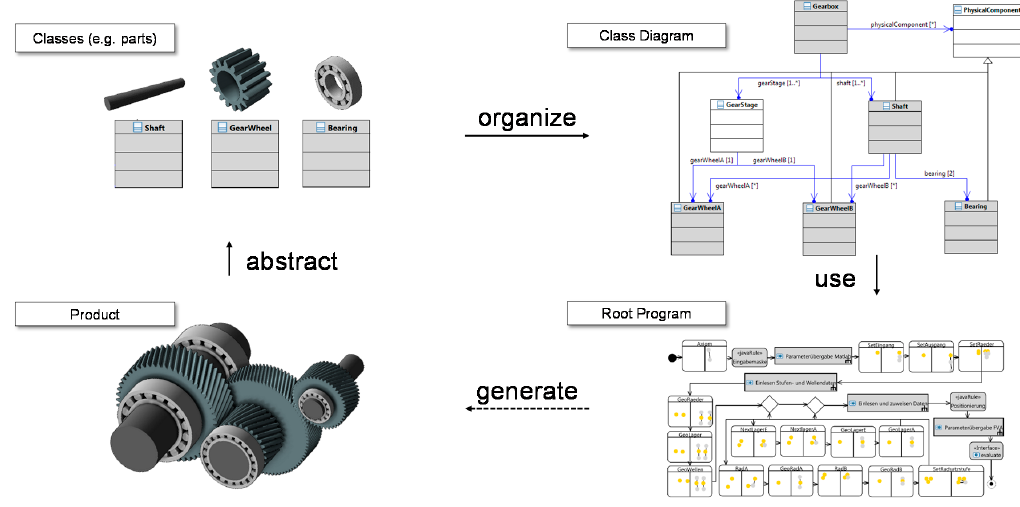
Figure 10. Scheme of the development process of a graph-based model for gear systems design variants.